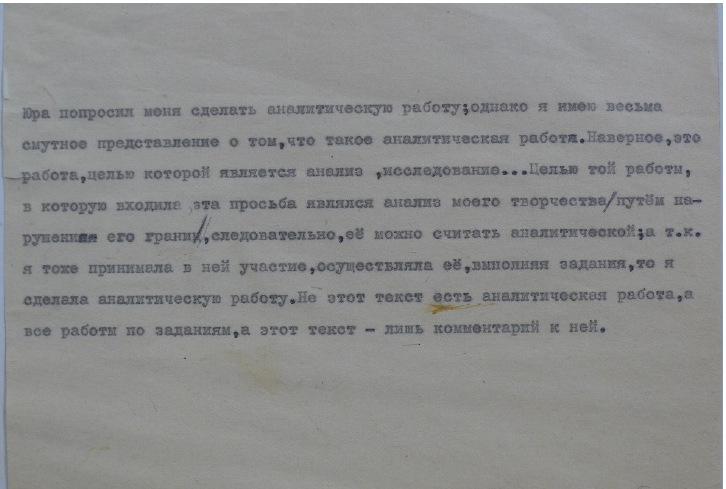
Figure 23. Stolpovskaya. Analytical work. 1980. Paper. 19.5 cm × 19.5 cm. Courtesy of the artist.